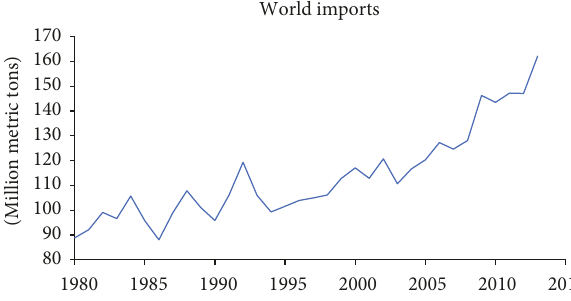
Figure 6: Annual world wheat imports. Source : FAO, 2015